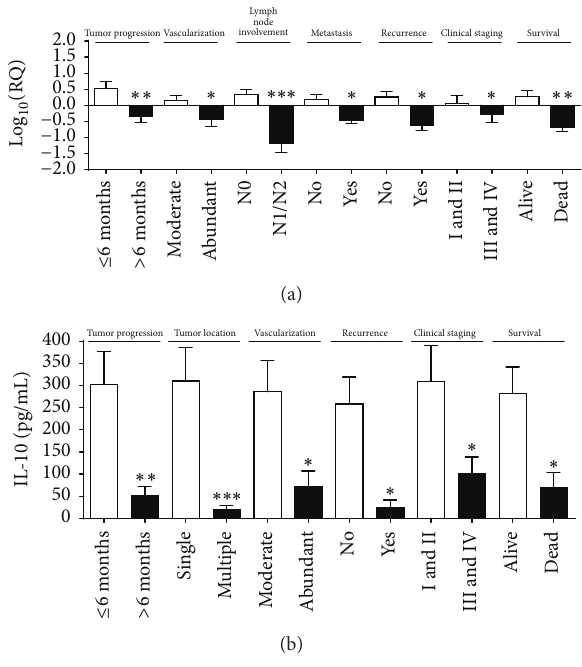
Figure 4: IL-10 gene overexpression correlated with (a) tumor progression for less than 6 months; moderate tumor vascularization; no lymph node involvement; no metastasis; no recurrence; clinical staging I or II; and animals that were alive at the end of the followup period. Higher IL-10 protein levels correlated with (b) tumor progression for less than 6 months; single tumor location; moderate tumor vascularization; no recurrence; clinical staging I or II; animals that were alive at the end of the followup period. Error bars ± standard error; ∗ 𝑝 < 0.05 ; ∗∗ 𝑝 < 0.01 ; ∗∗∗ 𝑝 < 0.001 indicate significant differences according to Student’s 𝑡